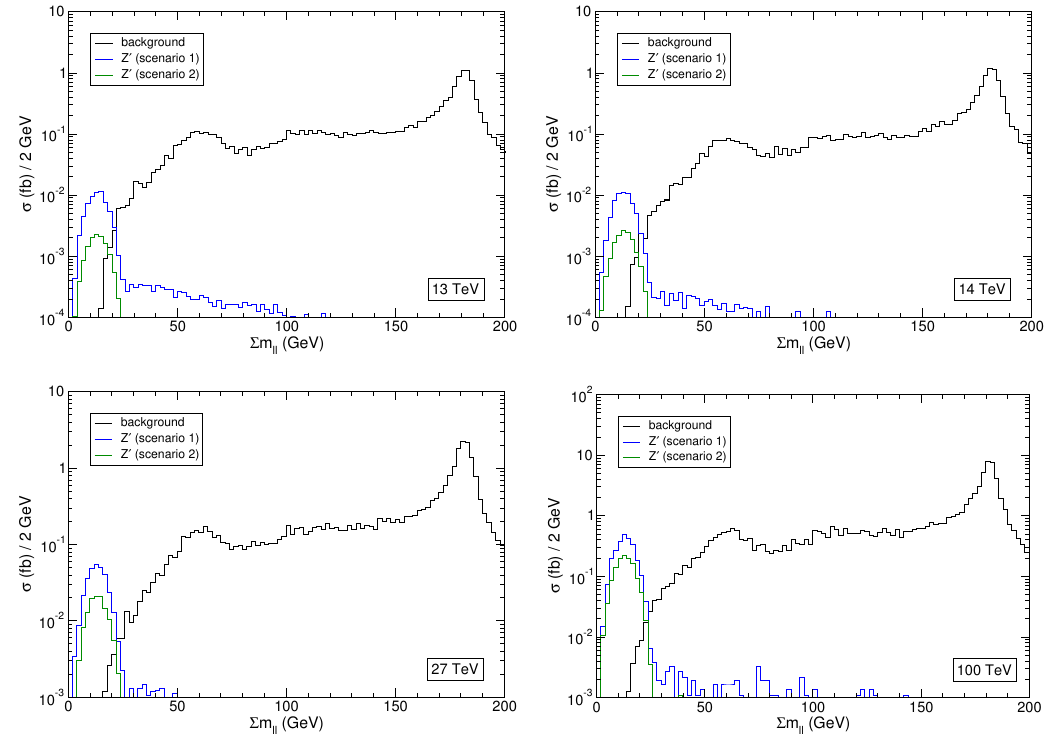
Figure 5 . Kinematical distribution of the minimum sum of dilepton invariant masses (cid:6) m ‘‘ for signals and backgrounds, for four CM